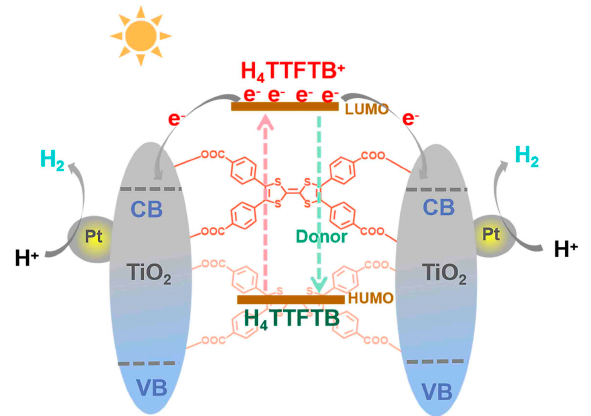
Figure 7. Proposed mechanism of photocatalytic H 2 production over Pt@H 4 TTFTB-TiO 2 .